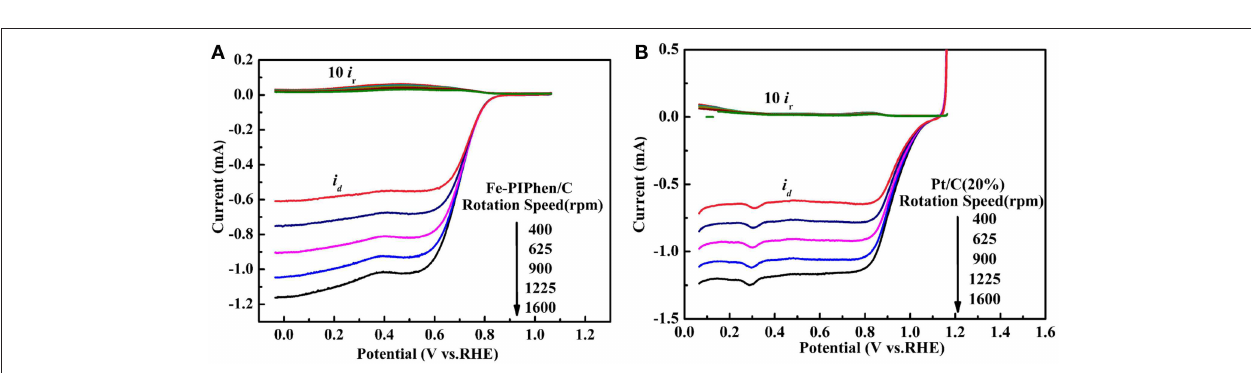
FIGURE 9 | Rotating ring disk electrode (RRDE) curves of Fe-PIPhen/C (A) , and Pt/C (20% content) (B) . Scan rate: 10 mV/s.